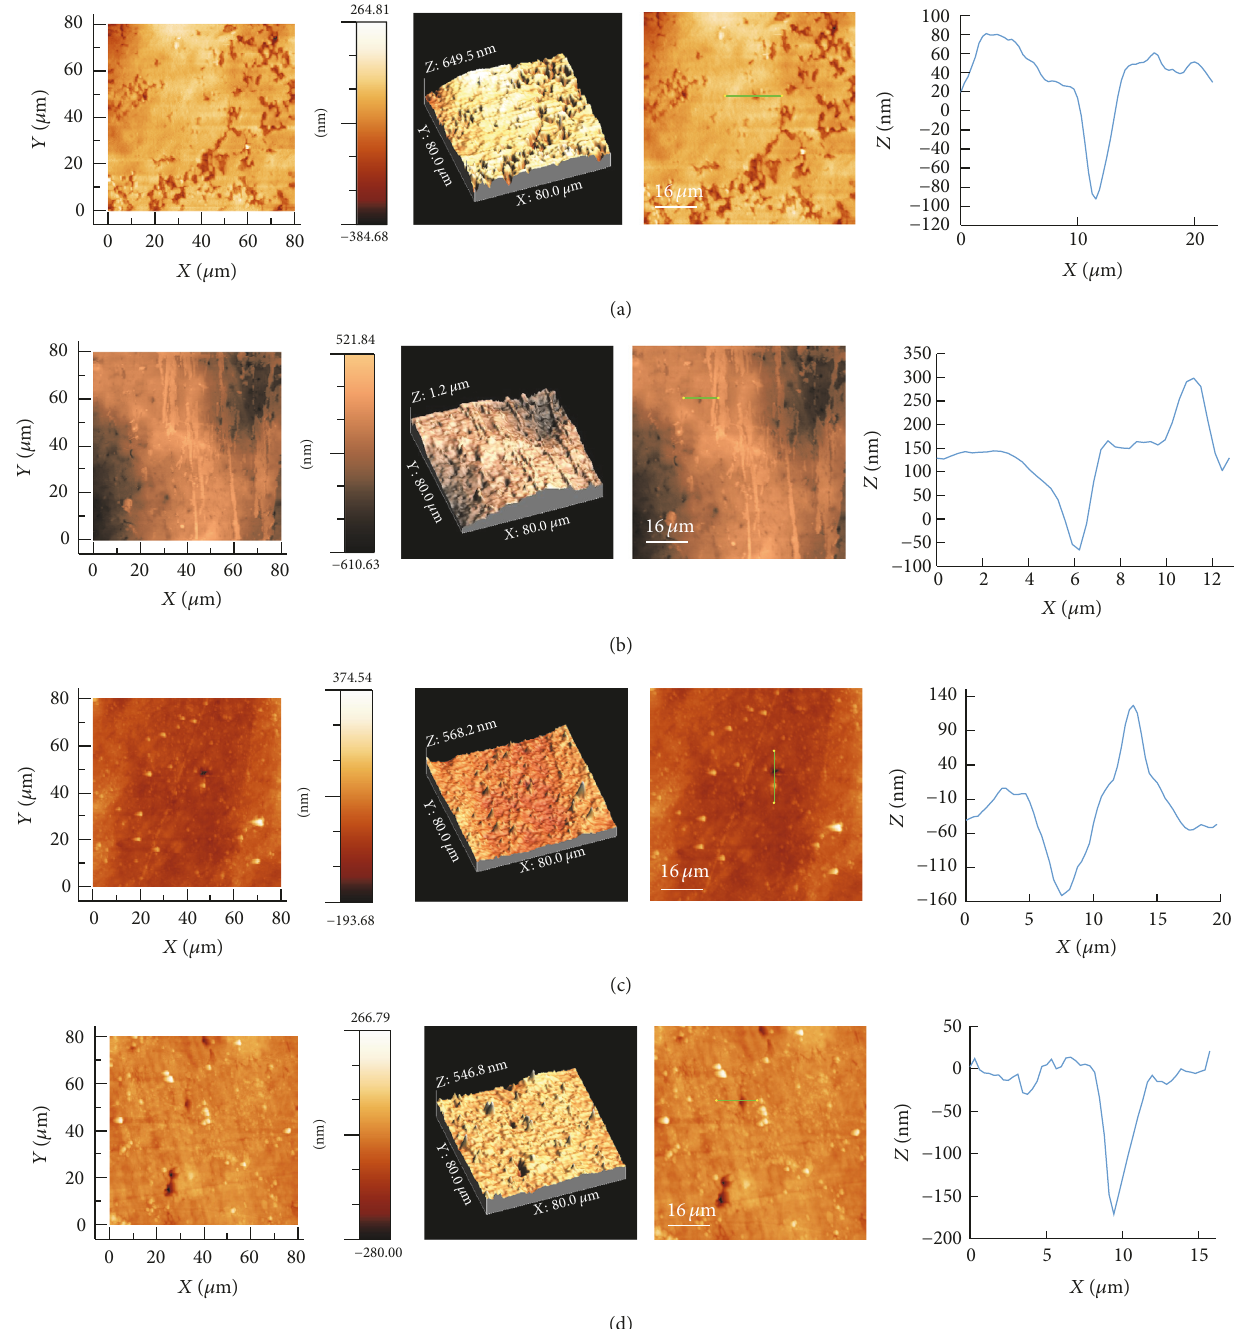
Figure 3: AFM topography images showing the surface and microhole profiles. (a) RPP; (b) RPP/SEBS; (c) RPP/SIS20; (d) RPP/SIS30.